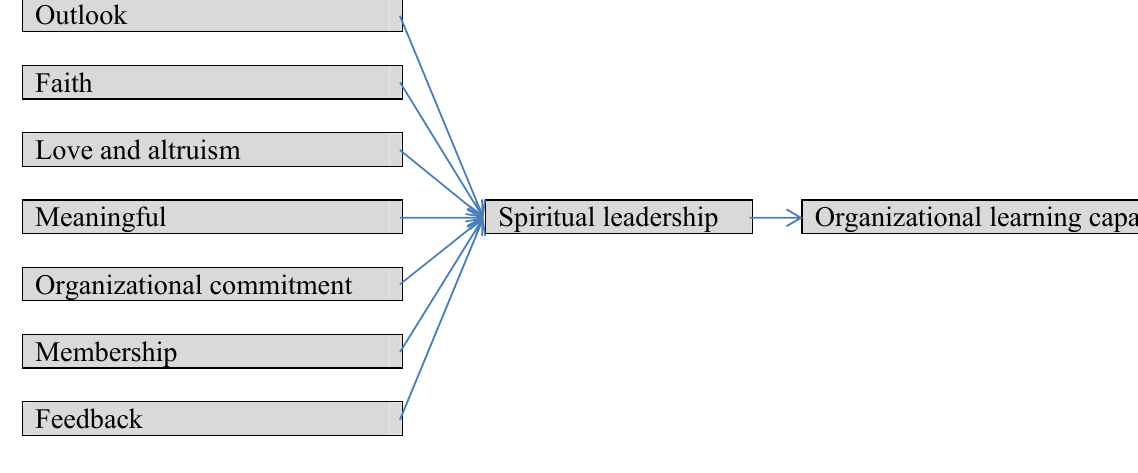
Fig. 1. The proposed